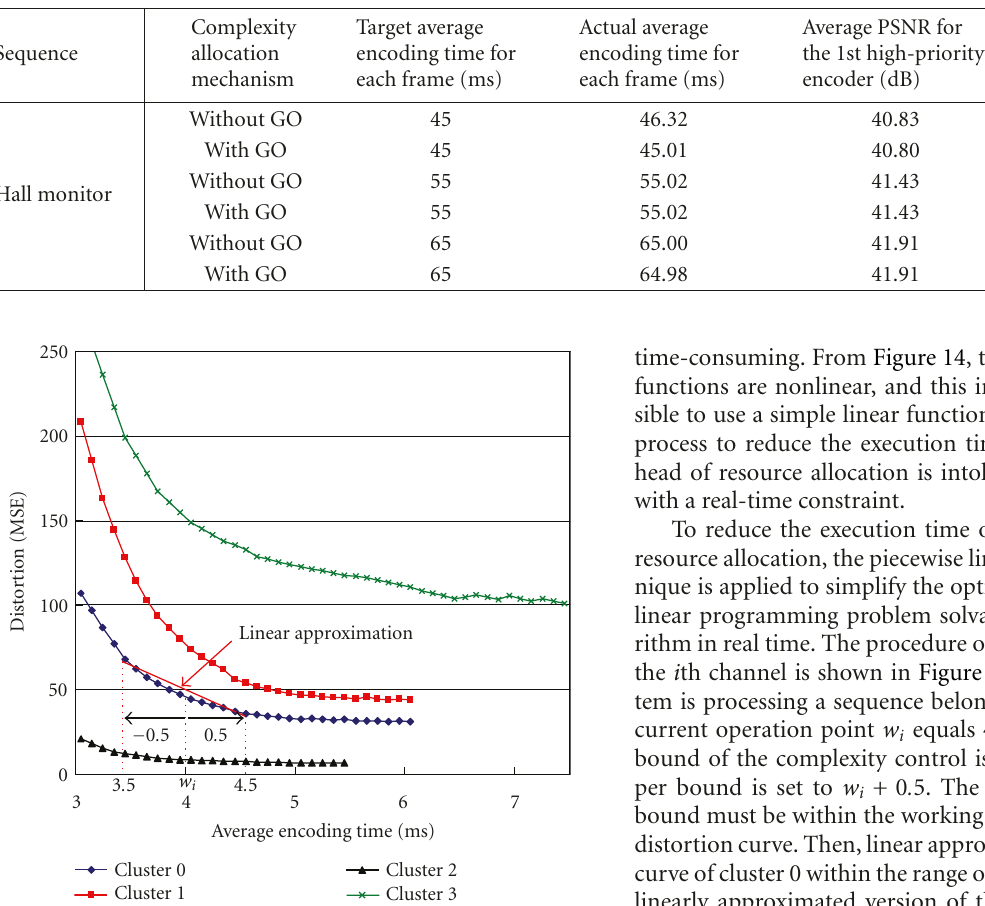
Table 5: Results of resource allocation with GO versus without GO for two high-priority and four low-priority channels.